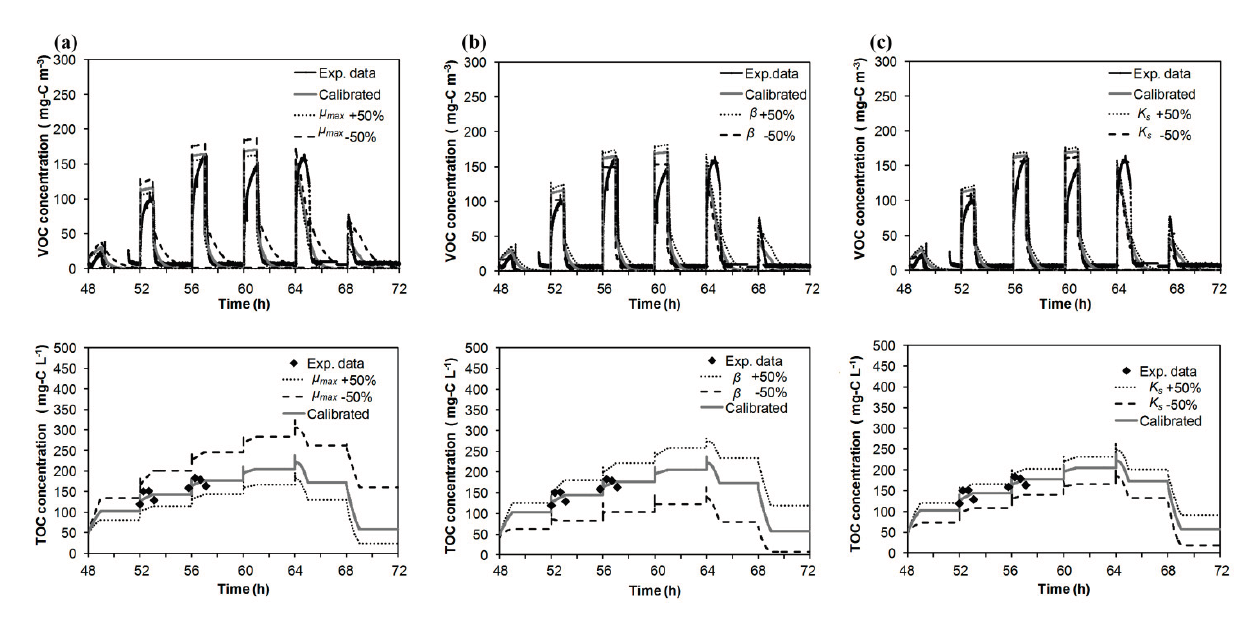
Figure 6. Effect of ( a ) µ max , ( b ) β and ( c ) K s on the outlet gas-phase concentration and